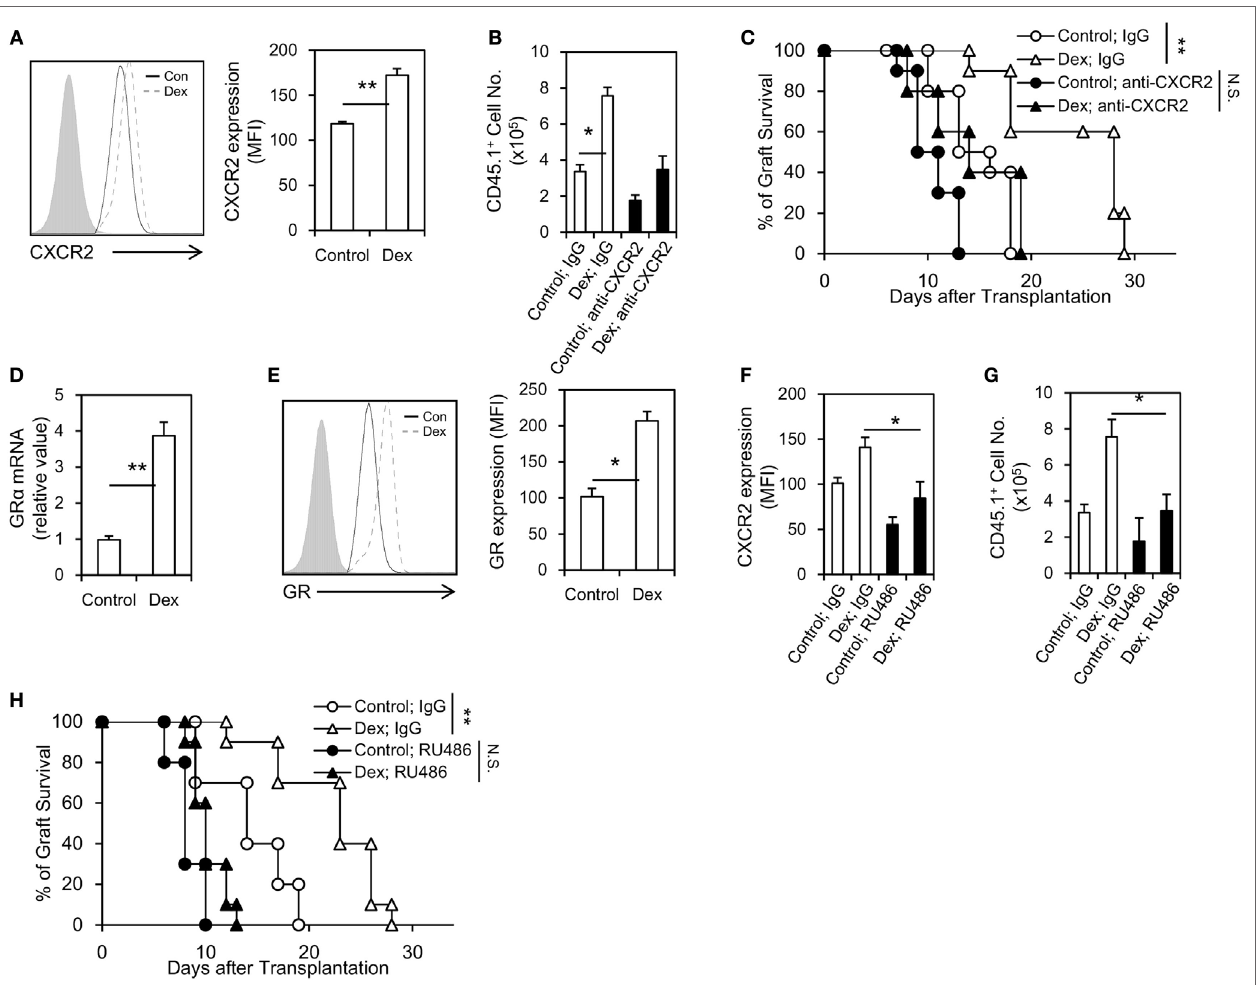
FigUre 4 | Dexamethasone (Dex) treatment promotes Myeloid-derived suppressor cells (MDSCs) migration into cardiac allograft through upregulating the expression of glucocorticoid receptor (GR) and CXCR2. CXCR2 expression (a) in MDSCs induced by granulocyte macrophage colony stimulating factor (GM-CSF) or GM-CSF + Dex was determined by flow cytometry, and the mean fluorescent intensity (MFI) of CXCR2 was summarized. Allograft recipient mice (CD45.2, C57BL6/J) were administered 50 µg neutralizing anti-CXCR2 mAb or IgG isotype control via i.v. injection 1 h before transplantation, and then MDSCs induced by GM-CSF or GM-CSF + Dex (3 × 10 6 per mice, i.v.) from CD45.1 mice (C57BL6/J) were adoptively transferred into these recipients. The infiltrating donor CD45.1 + CD11b + Gr-1 + cell number (B) and graft survival (c) were determined ( n = 8). Dex treatment upregulated the expression of GR in MDSCs both at the protein (D) and mRNA levels (e) . The GR antagonist RU486 efficiently diminished the CXCR2 expression on MDSCs (F) and decreased the infiltration of donor CD45.1 + CD11b + Gr-1 + MDSCs in cardiac allograft (g) . RU486 treatment (10 mg/kg, i.p., 1 h before transplantation) significantly diminished graft survival in recipient received MDSCs induced by GM-CSF + Dex (h) . Data (Mean ± SEM) are representative of two independent experiments ( n = 5–10 in each group). * P < 0.05, ** P < 0.01, N.S., not